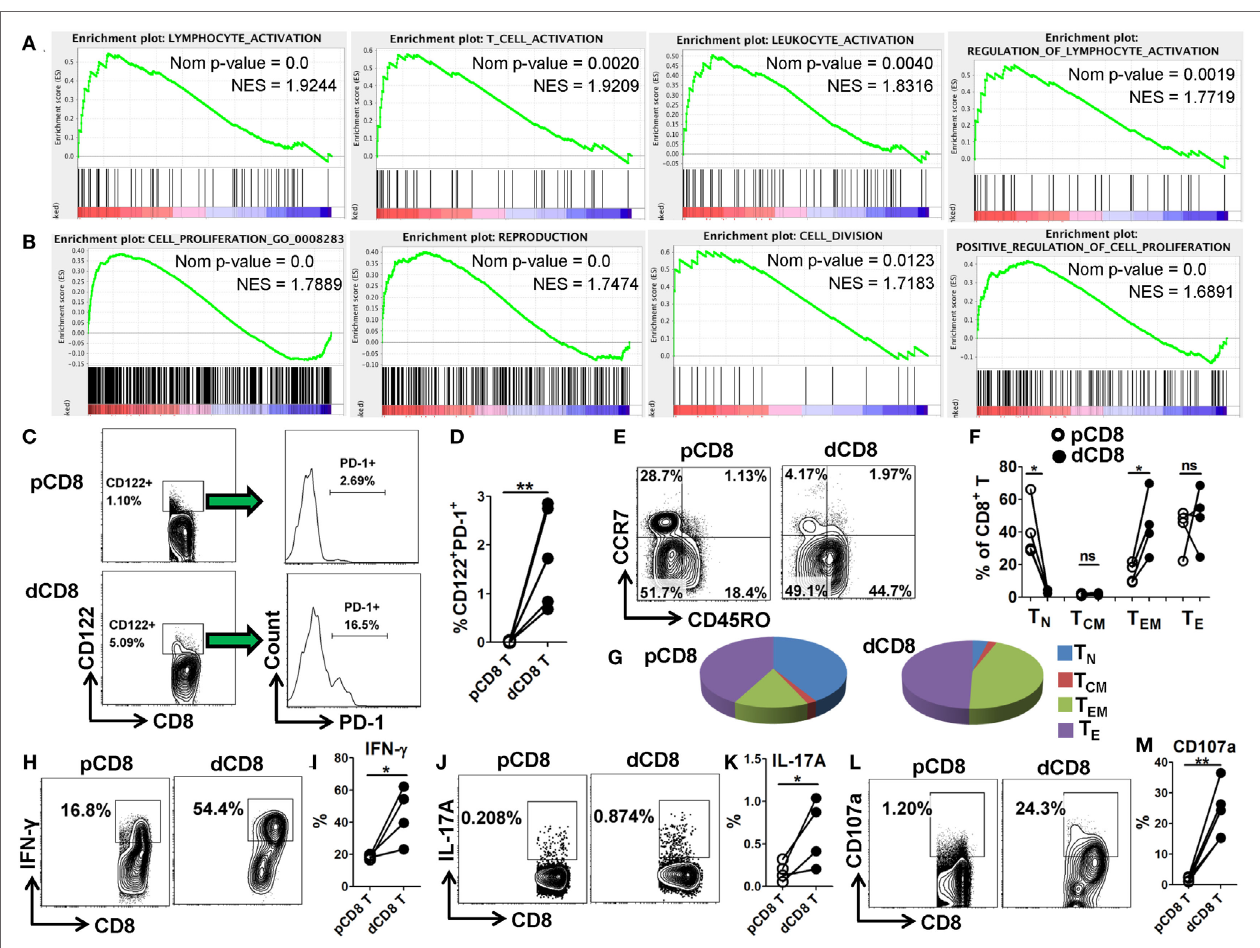
FigUre 4 | Human dCD8 T cells show increased activation and proliferation, display CD8-Treg and effector-memory phenotypes, and have an enhanced functionality. (a,B) GSEA plots of gene sets in GO categories including lymphocyte/T cell/leukocyte activation, regulation of lymphocyte activation (a) , and cell proliferation, reproduction, cell division, and positive regulation of cell proliferation (B) in human dCD8 versus pCD8 T cells. NES reflects the degree to which a gene set is upregulated (positive NES) in dCD8 cells and the corresponding nom P -value is indicated. (c,D) Representative flow cytometric plots/histograms (c) and cumulative data (D) displaying the proportion of CD122 + PD-1 + Treg cells among paired pCD8 and dCD8 T cells ( n = 5 per group). (e–g) Representative flow cytometric plots (e) , column chart (F) , and pie graphs (g) illustrating the proportions of native (T N , CD45RO − CCR7 + ), effector (T E , CD45RO − CCR7 − ), central memory (T CM , CD45RO + CCR7 + ), and effector-memory (T EM , CD45RO + CCR7 − ) T cells in paired pCD8 and dCD8 T cells ( n = 5 per group). (h–K) Comparison of IFN- γ and IL-17A production between in paired pCD8 and dCD8 T cells as determined by intracellular cytokine staining upon stimulation with PMA and ionomycin in vitro ( n = 4 per group). (l,M) Degranulation in PMA-ionomycin activated pCD8 and dCD8 T cells ( n = 5 per group), was measured by flow cytometric staining with anti-CD107a (LAMP-1) APC/Cy7 (5 μ L/well) included in the initial culture medium (RPMI 1640 supplemented with 10% fetal bovine serum). The flow cytometric data were assessed statistically using the paired Student’s t -test (D,i,K,M) or Wilcoxon matched pairs test (F) . Each symbol reflects a sample and each line reflects samples from the same person (D,F,i,K,M) . The flow data are representative of two independent experiments. Abbreviations: Nom, nominal; NES, normalized enrichment score; GO, gene ontology; GSEA, gene set enrichment analysis; pCD8 T, peripheral blood CD8 + T; dCD8 T, decidual CD8 + T; %, percentage; PMA,